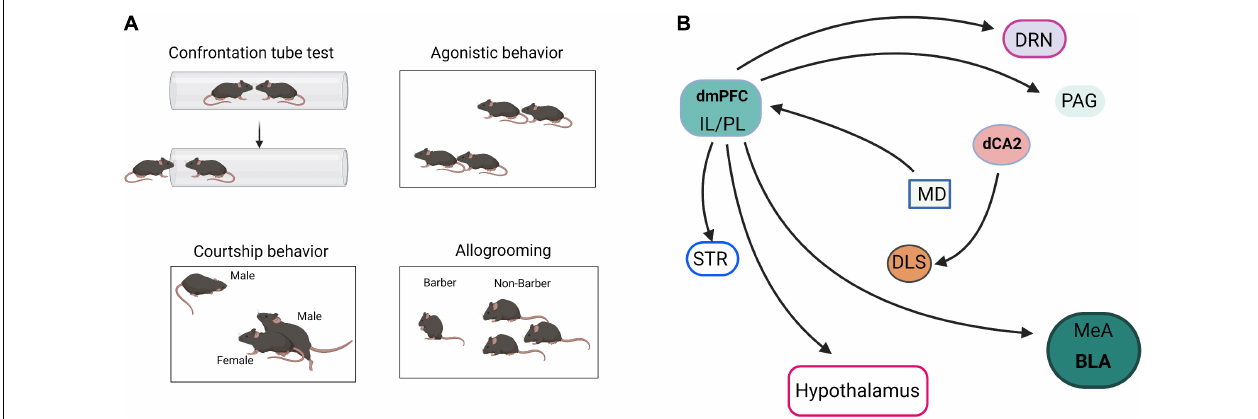
FIGURE 3 | Neural pathways of social dominance. (A) The paradigm diagrams of social dominance behaviors. (B) The neural circuits of social dominance. dmPFC, dorsomedial prefrontal cortex; IL, infralimbic cortex; PL, prelimbic cortex; MeA, medial amygdala; BLA, basolateral amygdala; dCA2, dorsal CA2; DRN, dorsal raphe nucleus; MD, mediodorsal nuclei of thalamus; PAG, periaqueductal gray; STR, striatum; DLS, dorsal lateral